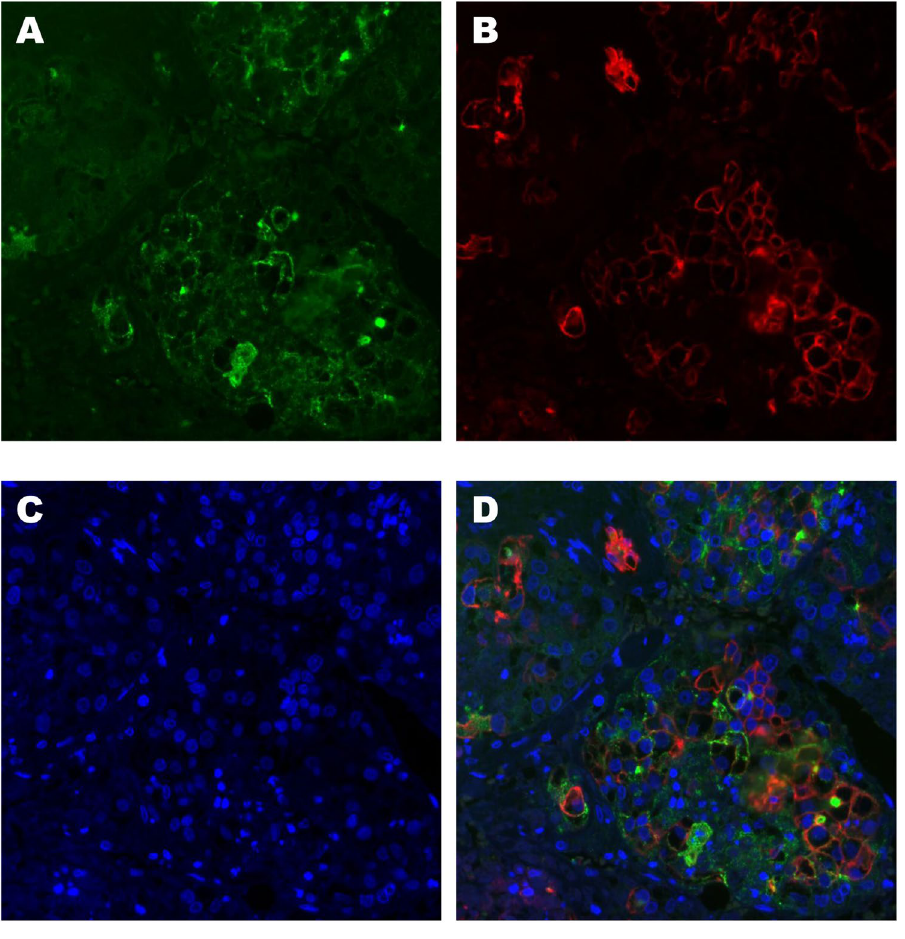
Figure 2. Double-staining for sialylated MUC1 and CK19. In sialylated MUC1 (green) positive tumor cells ( A ), CK19 (red) was also detected ( B ). The nucleus (blue) was stained with Hoechst 33342 ( C ). The merged image ( D ) showed coexpression of sialylated MUC1 and CK19 in some tumor cells.